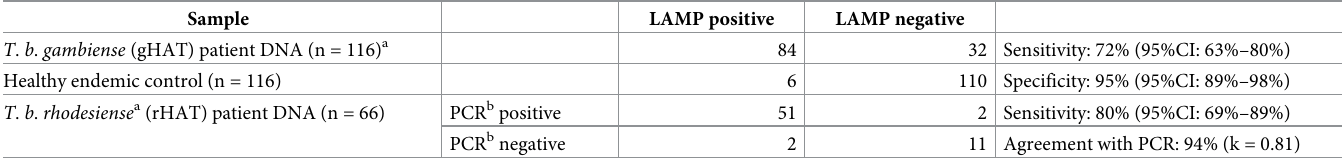
Table 1. CZC-LAMP HAT test results using the DNA extracted from rHAT, gHAT, and endemic control samples, and its agreement with the PCR test. Sample